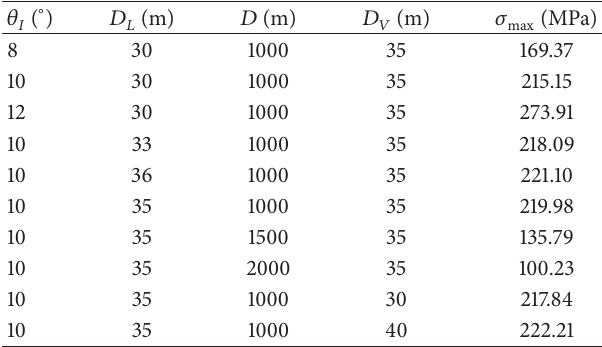
Table 3: Maximum stress results.